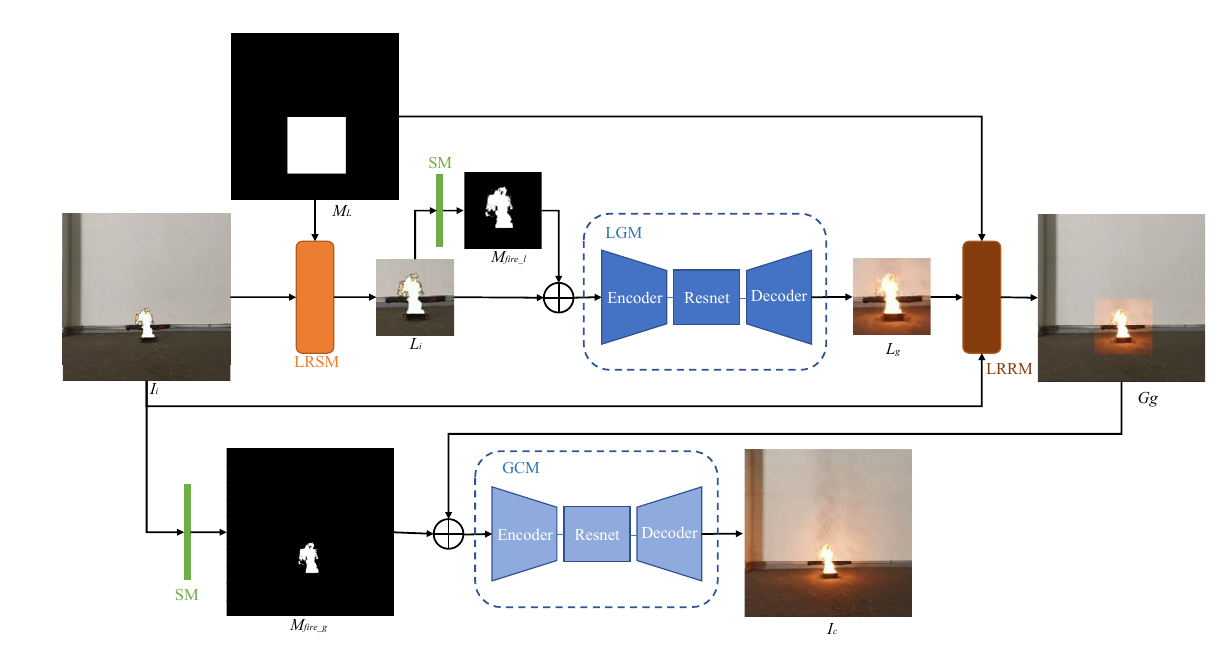
Figure 2. The generator structure.